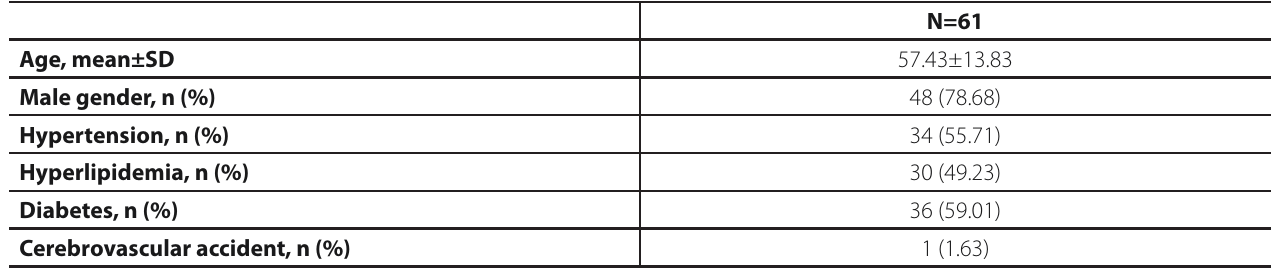
Brazilian Journal of Cardiovascular Surgery